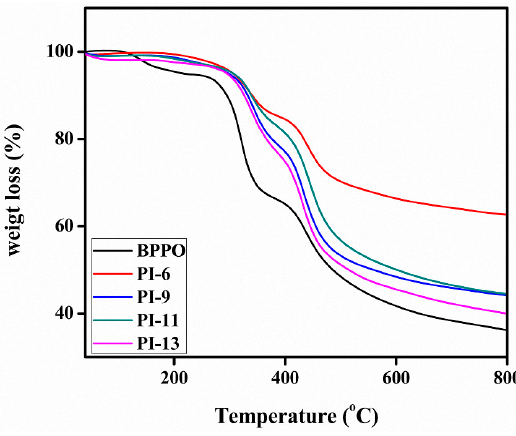
Figure 3. TGA thermograms of BPPO-based AEMs.